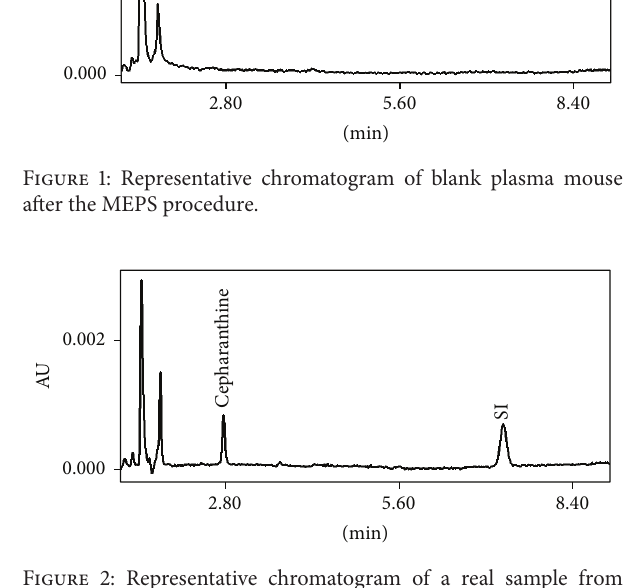
Figure 2: Representative chromatogram of a real sample from the pharmacokinetic study in mouse 4 hours after intraperitoneal administration of